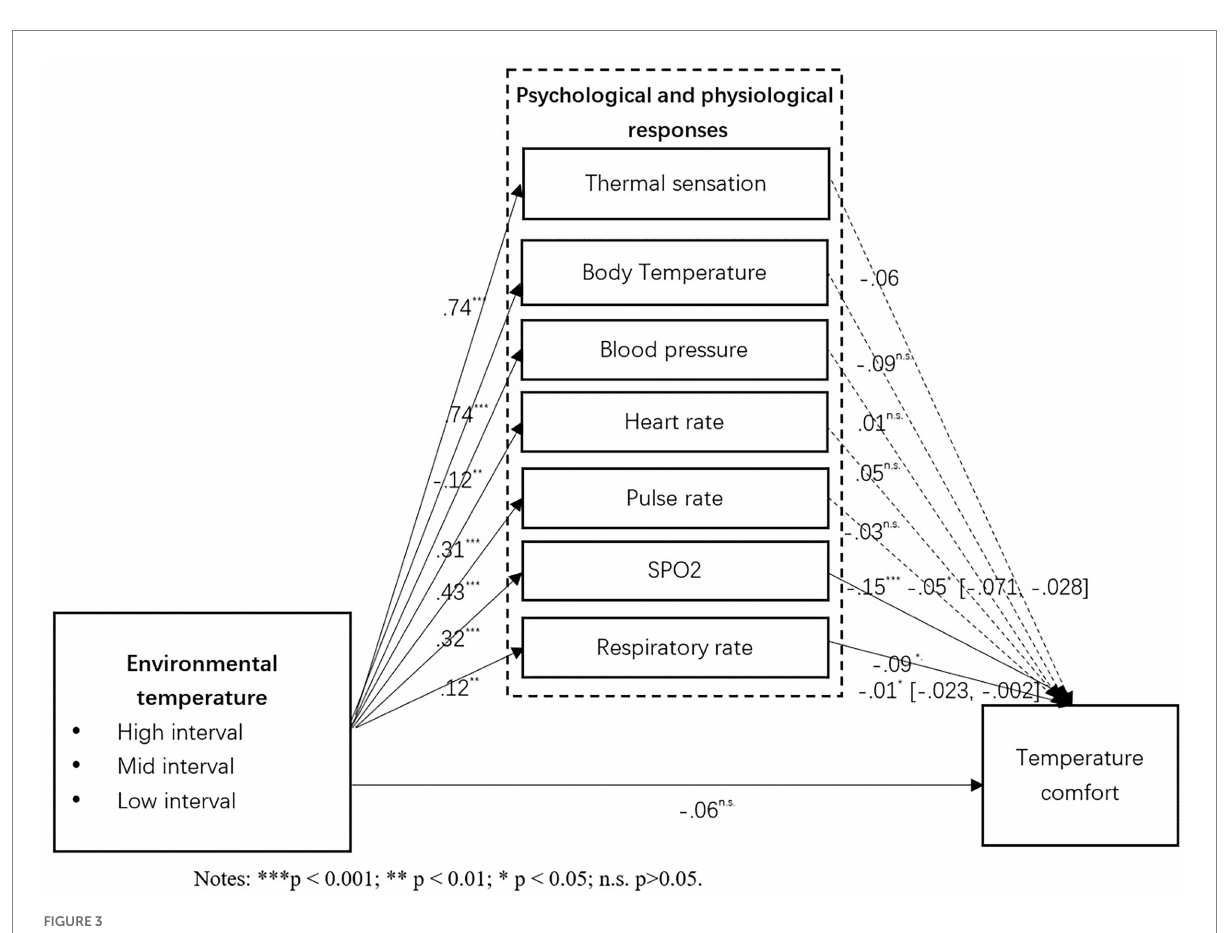
variables. As shown in Figure 4, the mediating effect of SPO2 (indirect effect B = 0.02; 95% CI = [0.008, 0.033]) has also been confirmed among audio condition and temperature comfort. As shown in Figure 5, the mediating effects of respiratory rate (indirect effect B = 0.009; 95% CI = [0.001, 0.022]) has been